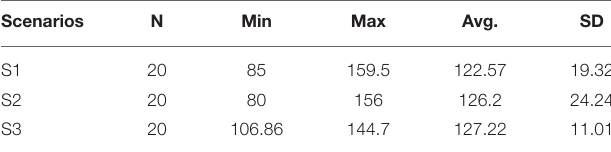
Table 2 | Latency (ms) summary for three test